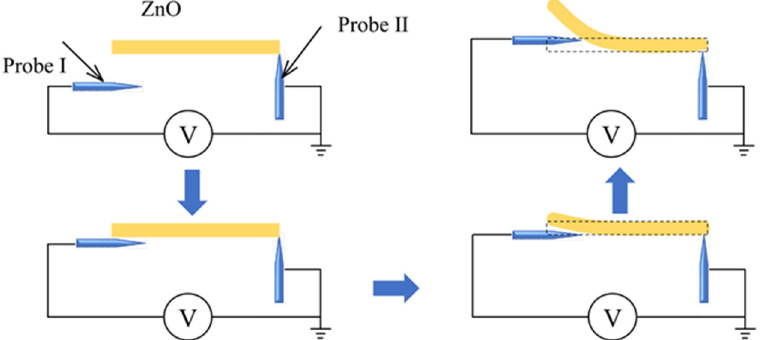
Figure 2. Principle of piezoelectric properties characterization. Yellow rectangle represents a single